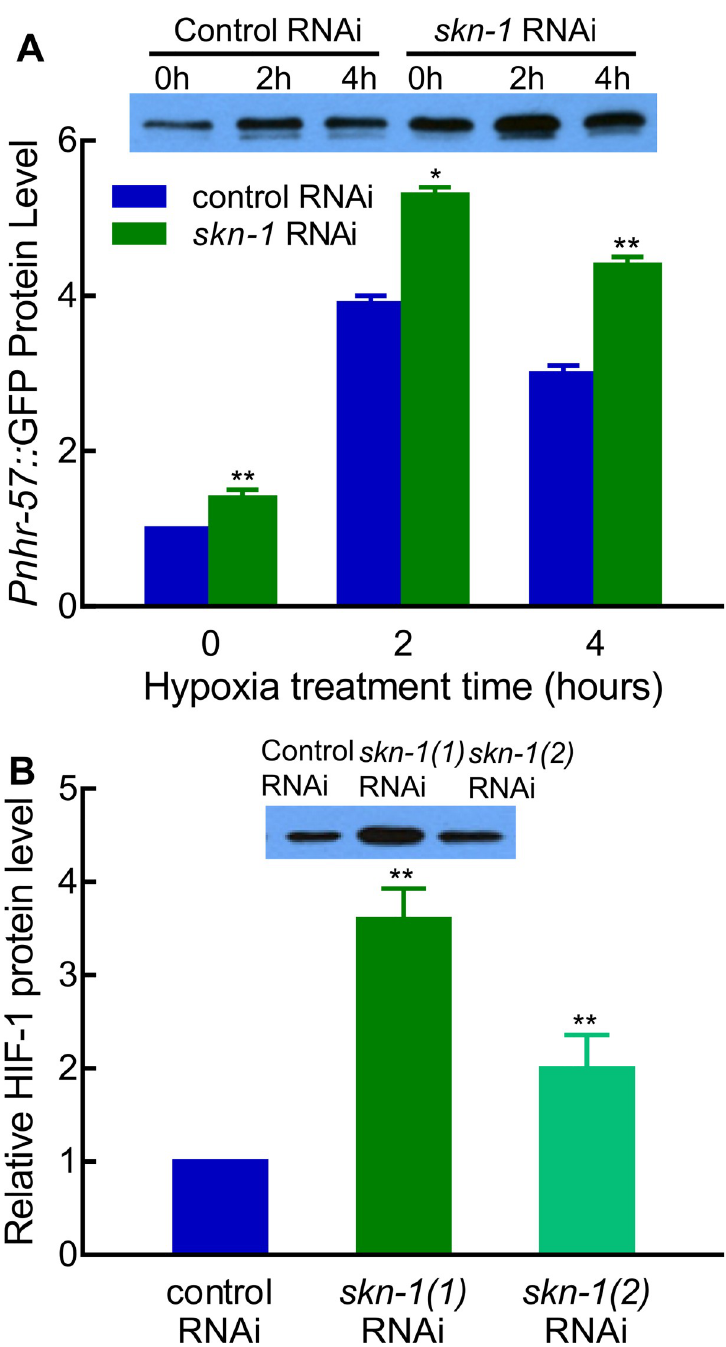
Fig 2. Identification of SKN-1 as a regulator of HIF-1. (A) skn-1 RNAi increased expression of the Pnhr-57 :: GFP reporter. Reporter gene expression was quantitated in L4-stage animals in normal culture conditions or after 2 or 4 hours of hypoxia treatment (0.5% oxygen). The protein levels were calculated from three independent experiments and normalized to 0 hour hypoxia control RNAi. A representative western blot is shown. In each lane, lysates from 80 L4-satge worms were loaded. Asterisks indicate significant differences between control RNAi and skn-1 RNAi at any given time point. � : p < 0.05; �� : p < 0.01. (B) skn-1 RNAi increased HIF-1 protein levels. These animals expressed an epitope-tagged HIF-1 protein [40]. The protein levels were calculated from three independent experiments and normalized to control RNAi. Two different RNAi clones were assayed, and they are designated as skn-1(1) and skn-1 (2) here. A representative western blot is shown. In each lane, lysates from 100 L4-satge worms were loaded. Asterisks indicate significant differences between control RNAi and skn-1 RNAi at any given time point. �� : p < 0.01.